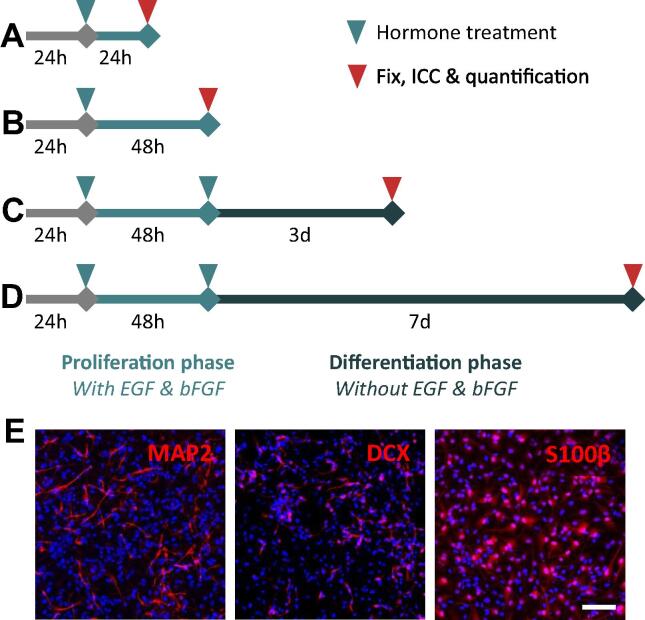
Schematics of the cellular assays performed to examine the effect of prolactin upon proliferating and differentiating hippocampal progenitor cells (HPCs). Schematics indicate the timing of treatments, and length of proliferation and differentiation phases in days. (A, B) Cells are cultured in media containing 4-OHT and growth factors (EGF and bFGF) for the duration of the proliferation phases (first 72 h). After 24 h cells are treated with either prolactin, estradiol or testosterone. After 24 h or 48 h cells are fixed and processed for ICC and quantification of cellular markers. (C, D) After the initial proliferation phase, cells undergo two full media washes with differentiation media (lacking EGF, bFGF and 4-OHT) and are cultured for the remaining assay tie in differentiation media containing treatment. (E) Three days after the initiation of differentiation, cells are supplemented with an additional hormone treatment to ensure prolactin levels remain at the target concentration throughout the differentiation phase. (E) Representative images of HPCs allowed to differentiate for 7 days, illustrating the ability to produce DCX and MAP2-positive neurons and S100β-positive astrocytes. DAPI nuclear staining shown in blue. Scale bar = 100 μm.